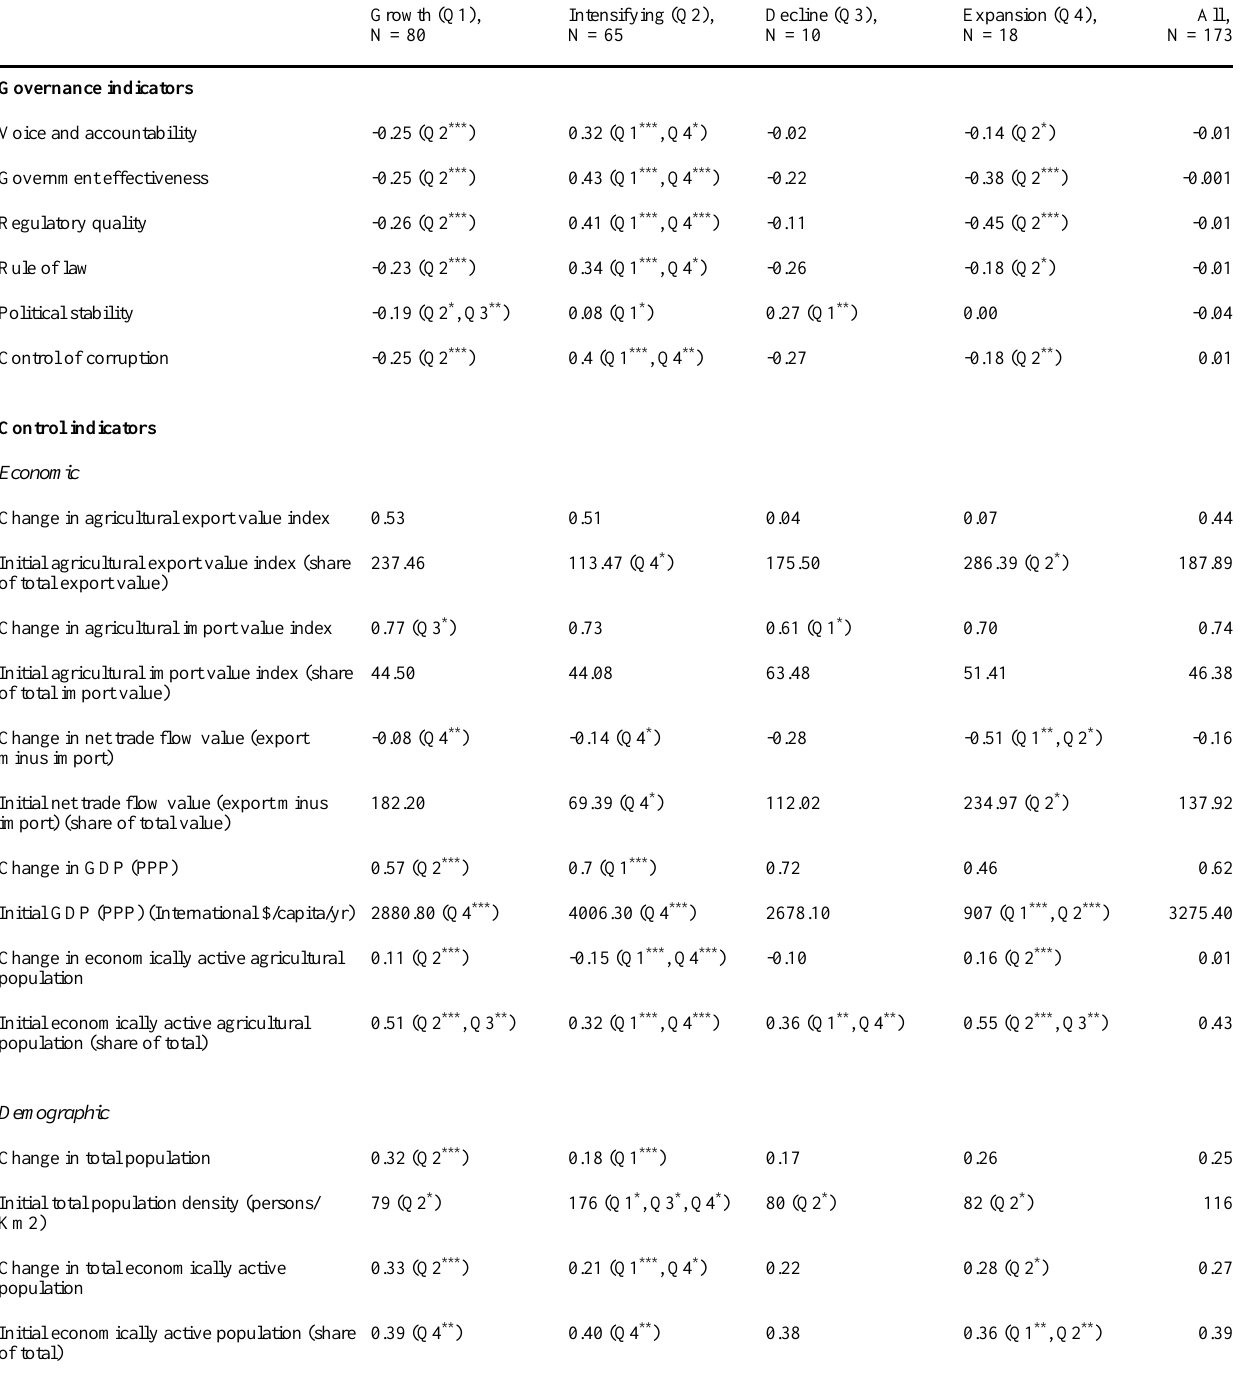
Table 2. Between groups analysis of means. Mean values of indicators per quadrant, and in parentheses the other quadrants from which means significantly differ according to T-tests. On the right, total means of these variables. p £ 0.1*, p £ 0.05**, p £ 0.01*** Statistical software: R for statistical computing version 2.8.0